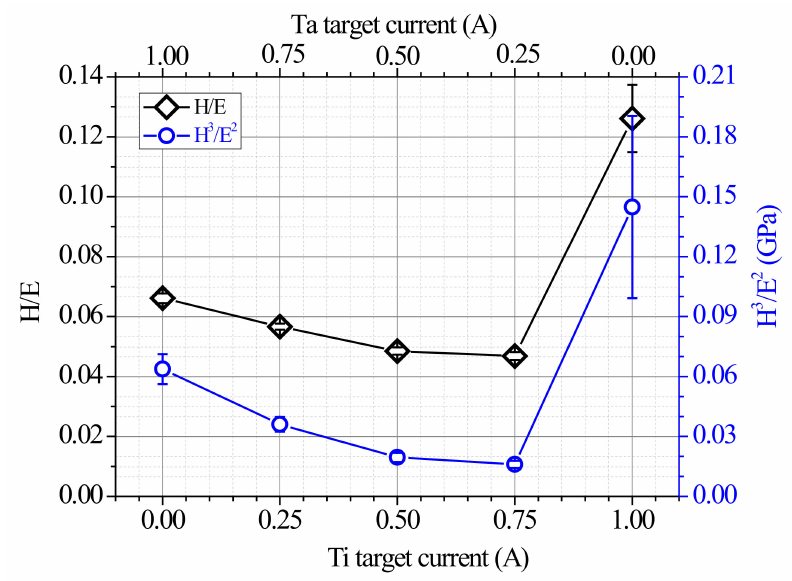
Figure 5. The variation of the H / E and H 3 / E 2 ratios ( H / E —elastic strain to failure ratio, H 3 / E 2 —indicator of a material’s resistance against plastic deformation) as a function of Ti and Ta target currents.